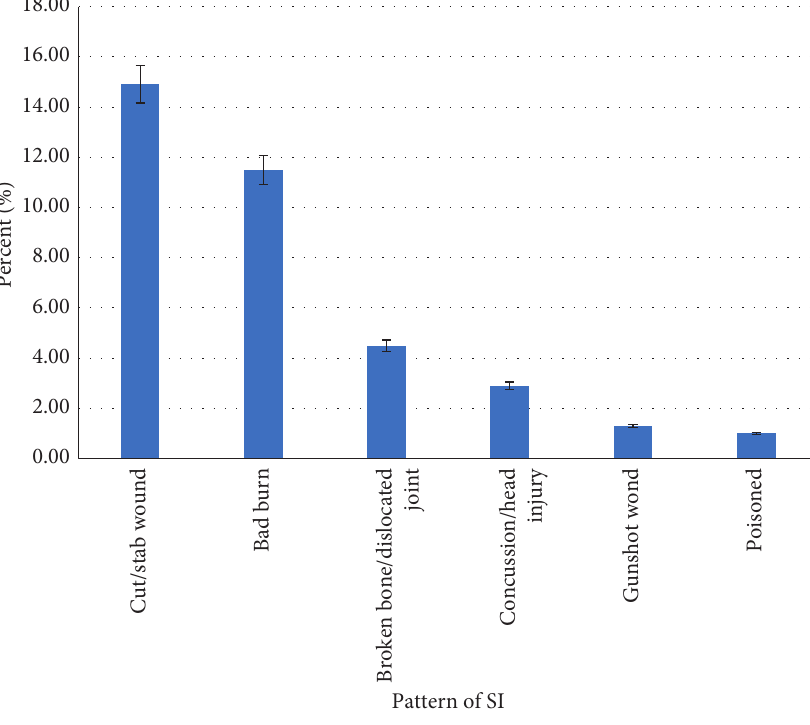
Figure 2: Pattern of serious injuries among adolescents in Ghana.